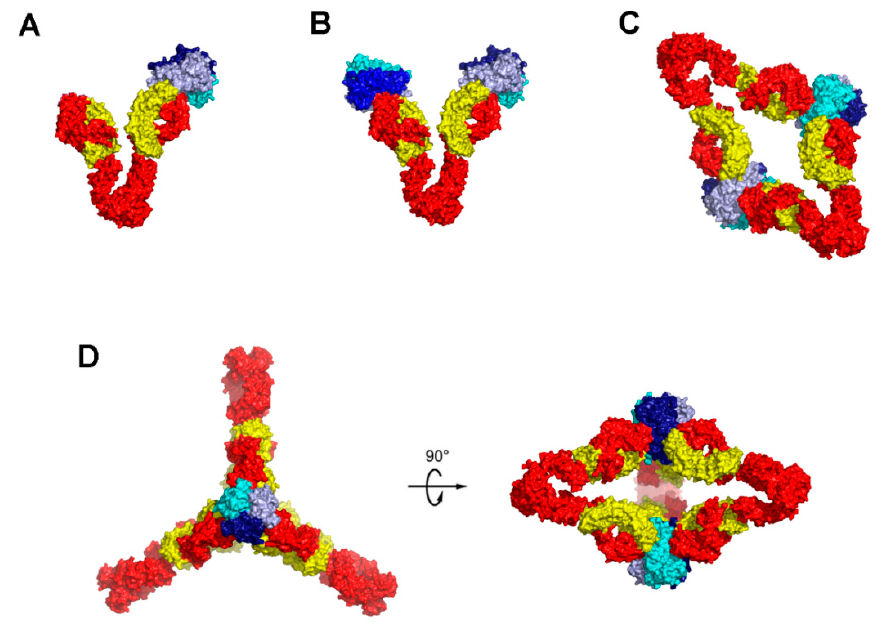
Figure 5. Models of the complexes of full-length adalimumab and TNF α trimers. The models are derived by fitting a TNF α trimer (blue, pale blue, and cyan) and bound Fab fragments (heavy chain: red, light chain: yellow) of PDB ID 3WD5 to the cryo EM electron density. ( A ) 1:1 complex; ( B ) 1:2 complex; ( C ) 2:2 complex; ( D ) 3:3 complex.